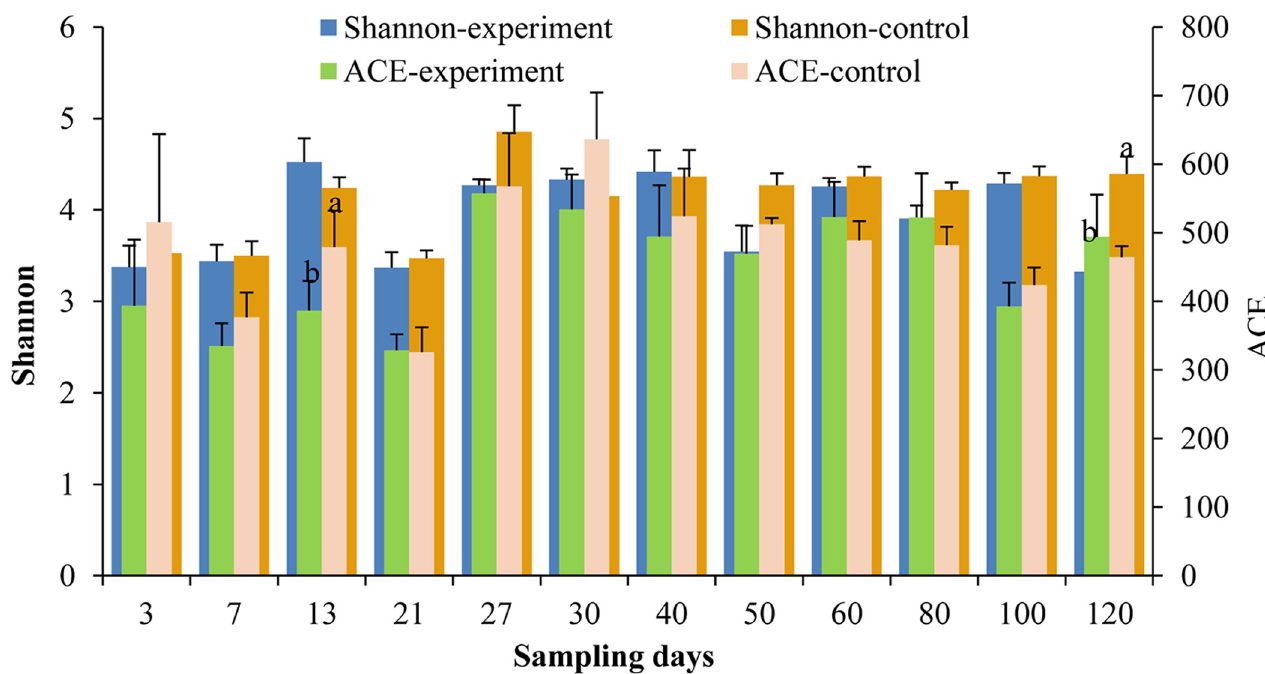
Fig 3. Abundance-based coverage estimator (ACE) and Shannon index for turbot larvae intestinal microflora during the developmental stage. The ACE or Shannon index for each sample was the average based on five replicates. Values with different letters differed significantly on the same day ( P < 0.05).